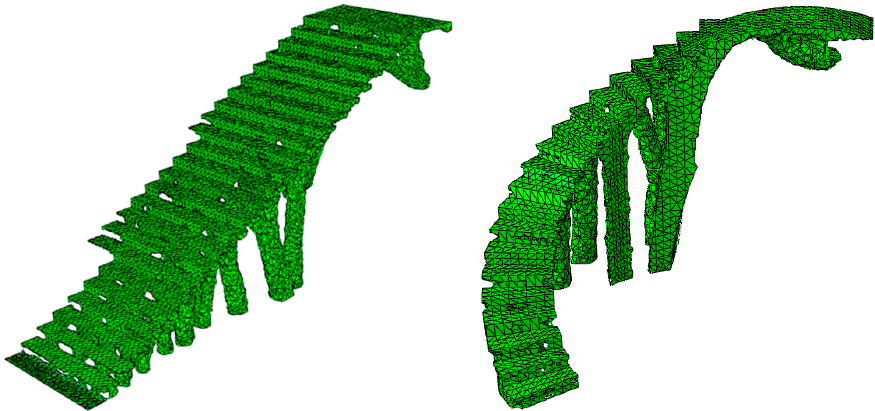
Figure 16. Evolution of the geometry of the bounding box B 2 throughout the topological optimization process.